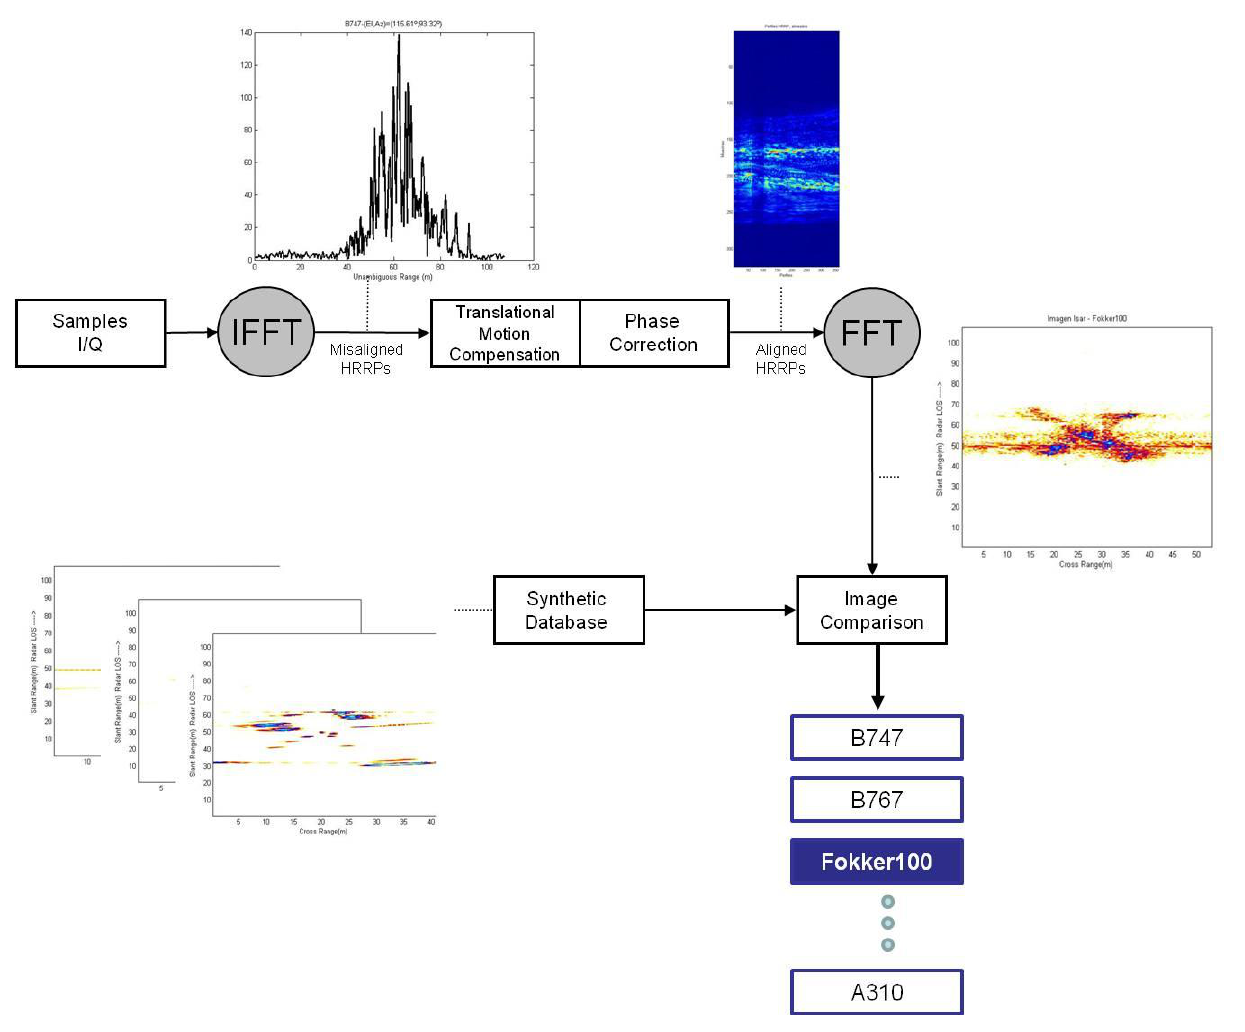
Figure 6. System identification